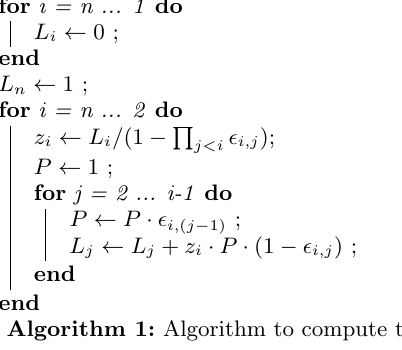
Algorithm 1: Algorithm to compute the TXcredit